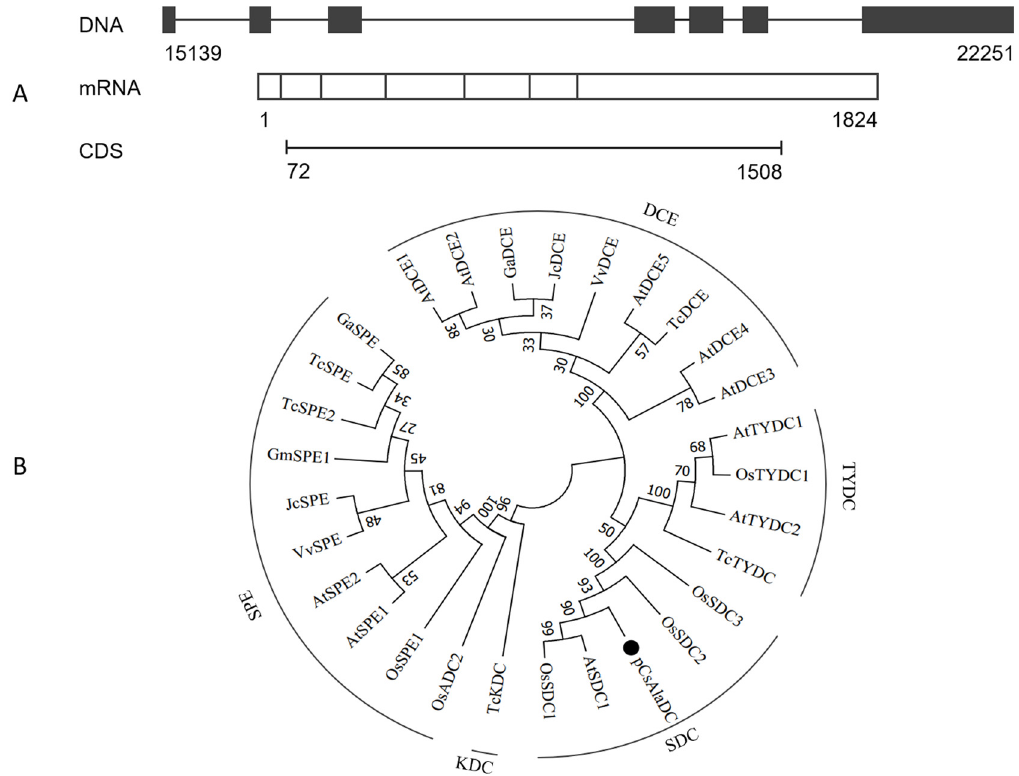
Figure 4. Cloning and sequence analysis of pCsAlaDC from tea plants. ( A ) Prediction of the gene structure using online software Splign. The genome sequence of the gene was obtained from the “Shuchazao” genome. ( B ) Phylogenetic relationship of pCsAlaDC from the tea plants with amino-acid decarboxylases from other species. The sequences of amino-acid decarboxylases from seven plant species were obtained from the UniProt database. The alignment was conducted using the ClustalW method, and the phylogenetic analysis was performed using the neighbor-joining method with MEGA7 software; pCsAlaDC is denoted by a dot. SDC, serine decarboxylase; TYDC, tyrosine decarboxylase; DCE, glutamate decarboxylase; KDC, lysine decarboxylase; SPE or ADC, arginine decarboxylase. At, Arabidopsis thaliana ; Os, Oryza sativa ; Gm, Glycine max ; Tc, Theobroma cacao ; Ga, Gossypium arboreum ; Vv, Vitis vinifera ; Jc, Jatropha curcas .